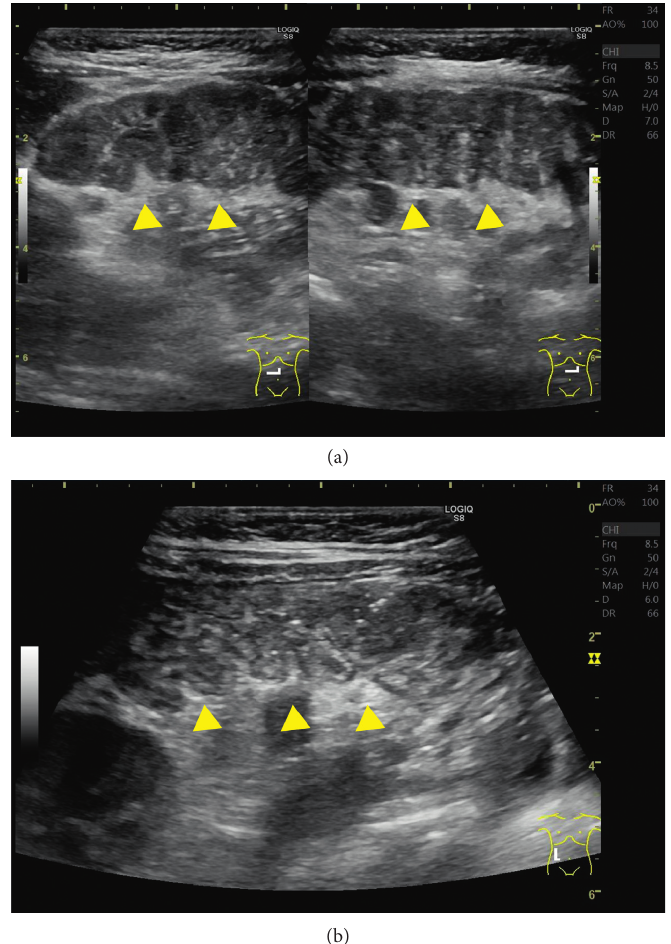
Figure 3: Abdominal ultrasonography revealing intraperitoneal lymphadenopathy, wall thickness of the entire